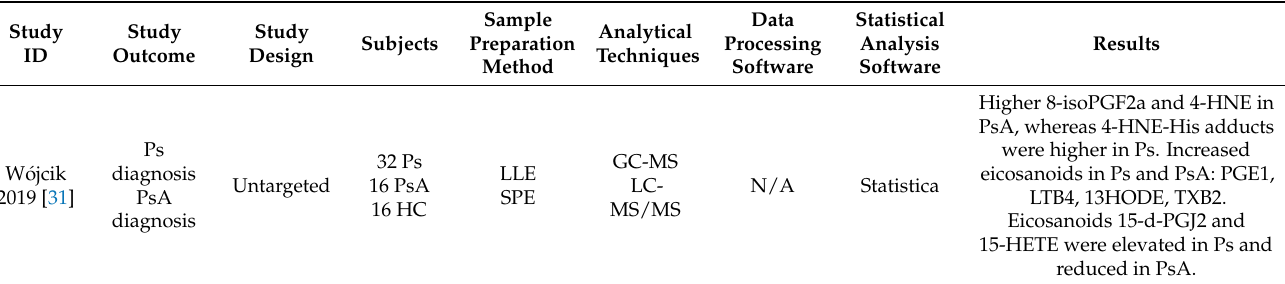
Table 4. Studies in peripheral blood mononuclear cells.